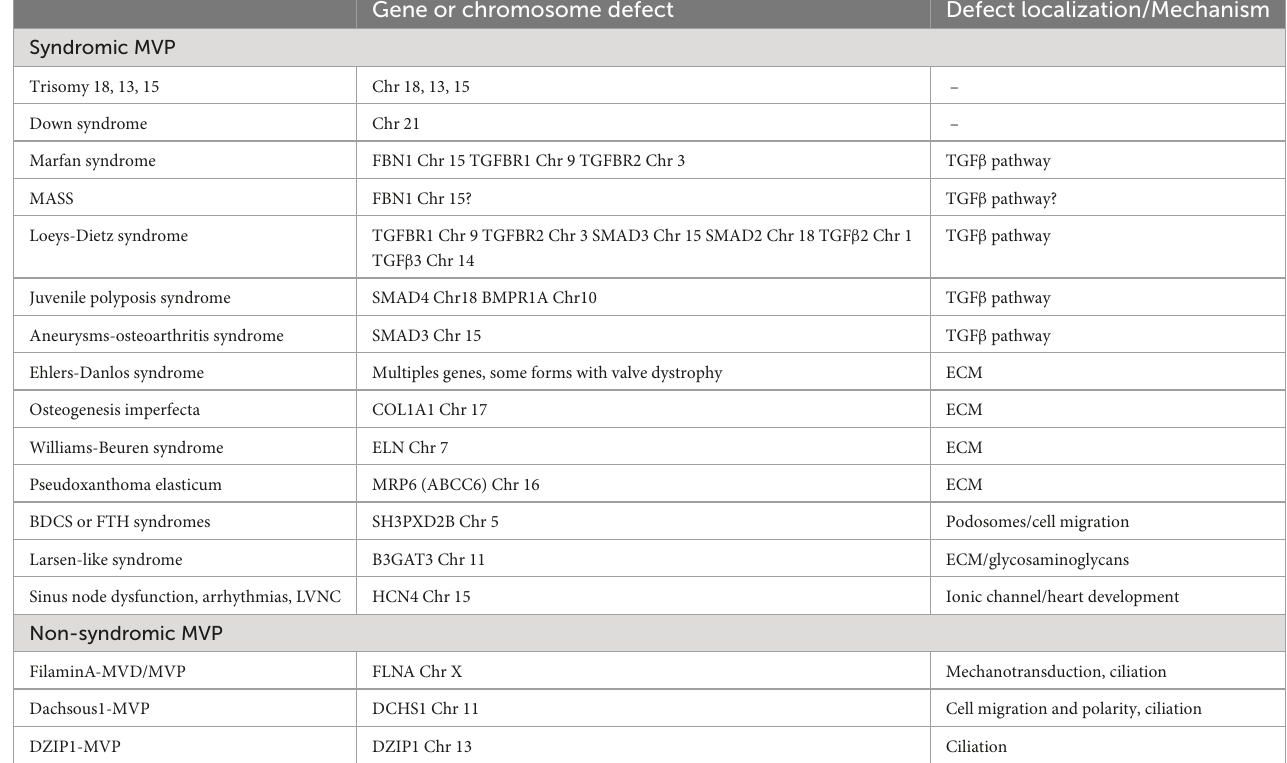
TABLE 1 Genetic anomalies associated with mitral valve prolapse in